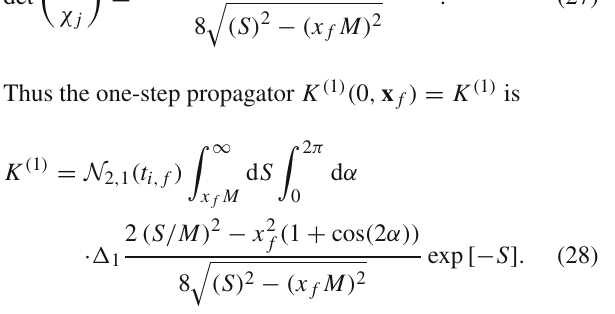
In two Euclidean dimensions ( x = ( x (λ), y (λ)) ), the rela- tivistic path integral (22)